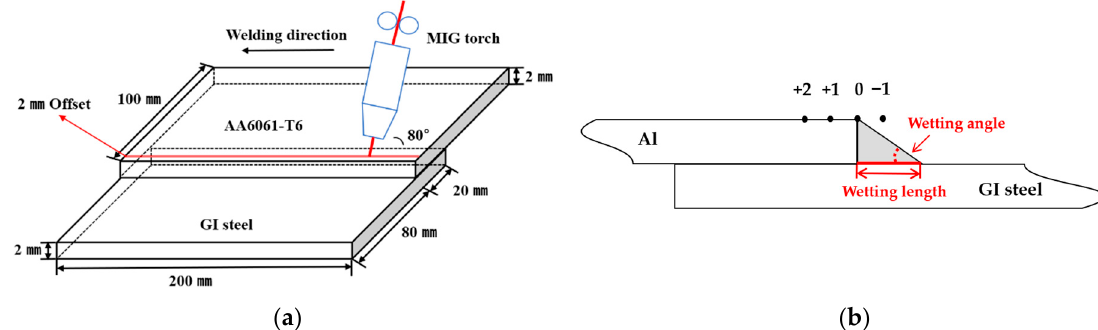
Figure 1. Schematic of AA6061-T6 and GI steel welded joints specimen: ( a ) AA6061-T6 and GI steel welded joint; ( b ) definition of torch aiming position, wetting length, and wetting angle.